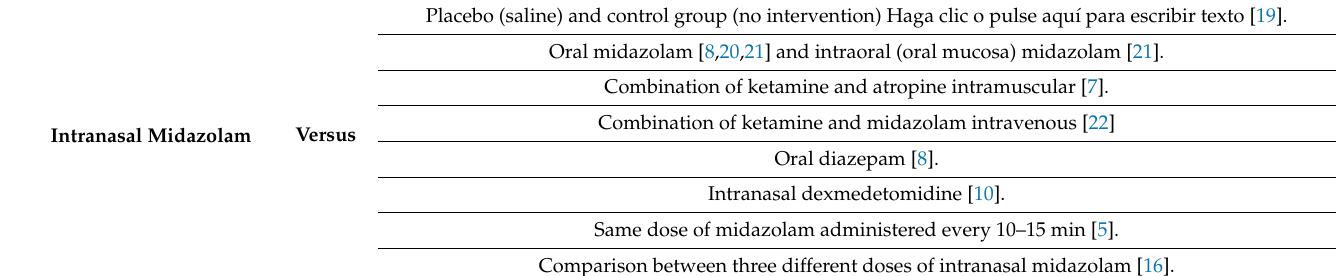
Table 3. Comparison of intranasal midazolam.